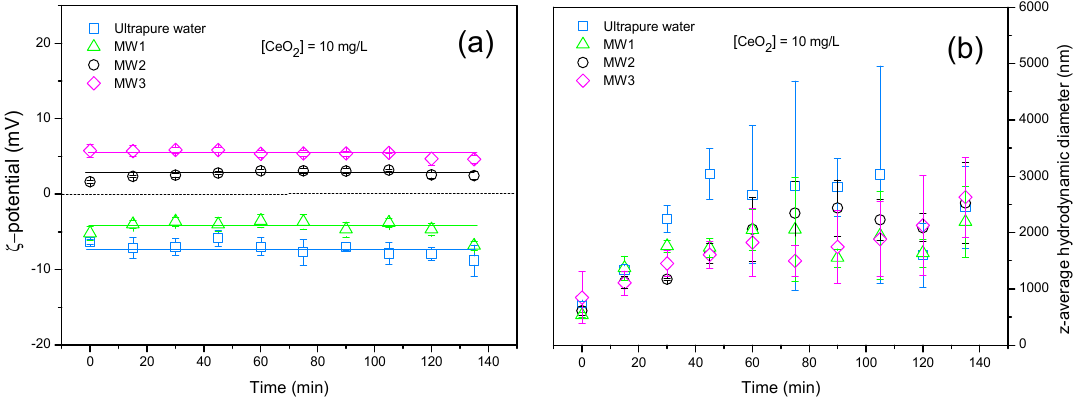
Figure 6. ( a ) ζ potential and ( b ) z-average hydrodynamic diameter variation of CeO 2 as a function of time in ultrapure water at pH = 7.0 ± 0.1 and mineral waters at their natural pHs. CeO 2 NPs surface charge is found to be reduced in all mineral waters, hence promoting CeO 2 aggregation .